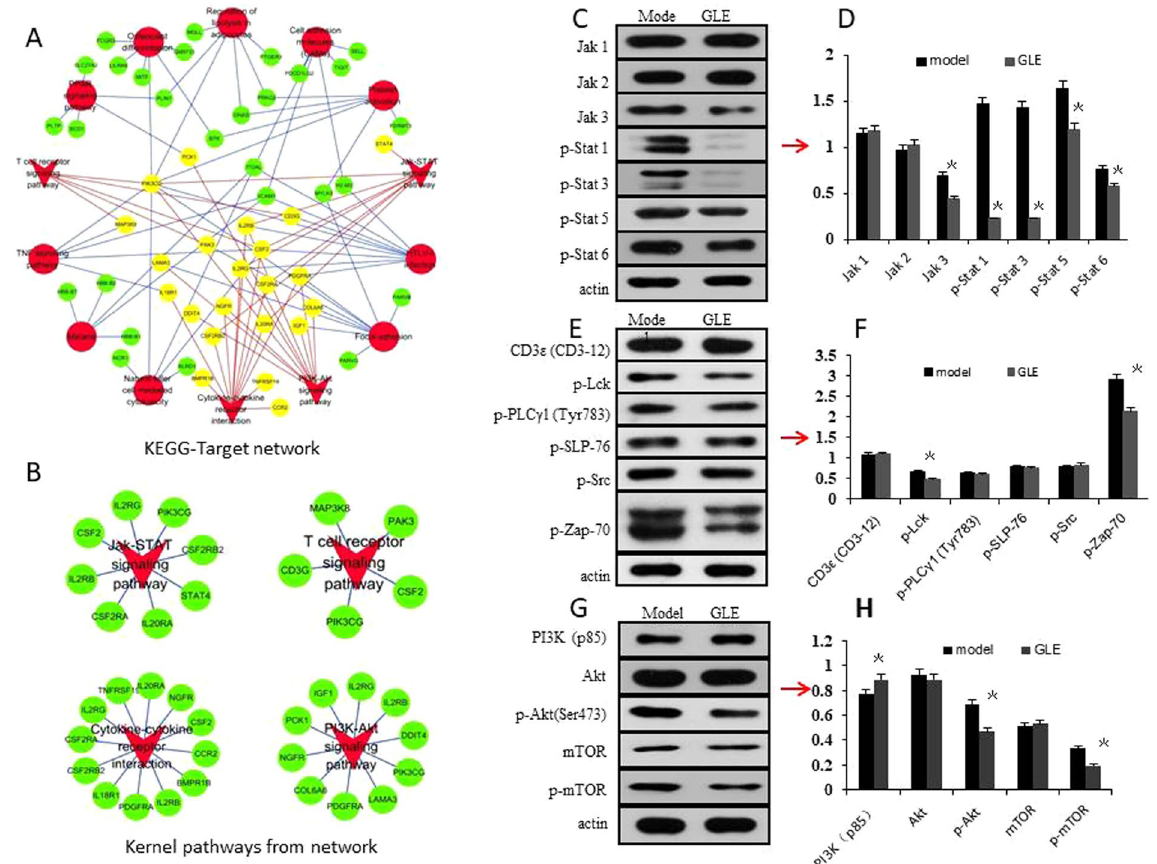
Figure 6. The kernel biological pathway screening and validating was based on the KEGG-Target network and Western-blot. ( A ) The KEGG-Target pathway network was constructed based on the differential expressed genes and their KEGG pathways. The red dot represents each KEGG pathway, the green dot represents target genes, and the red triangles represent the selected important pathways in network, including Jak-STAT signaling pathway, T cell receptor signaling pathway, PI3K-Akt signaling pathway, and cytokine-cytokine receptor interaction. The yellow dot represents the target genes of four selected pathways. ( B ) Four kernel pathways selected from the KEGG-Target network. ( C ,D) The effects of GLE were validated on the Jak/Stat signaling pathway. Compared with those in the model group, the expression levels of JAK3, p-Stat1, p-Stat3, p-Stat5 and p-Stat6 were significantly inhibited by GLE in vivo ( P < 0.05). ( E , F ) The effects of GLE were validated on the T cell receptor signaling pathway. The expression levels of p-Lck and p-Zap-70 were down-regulated ( P < 0.05). ( G , H ) The effects of GLE were validated on the PI3K/Akt/mTOR signaling pathway for proliferation inhibition. Compared with those in model group, the expression levels of p-Akt and p-mTOR were down-regulated ( P < 0.05), and PI3K was up-regulated ( P < 0.05). Densitometry analysis of the levels of these proteins relative to actin was performed. Representative results of three independent experiments are shown. The β -actin was used as a loading control. Error bars, SD; * P < 0.05, versus model